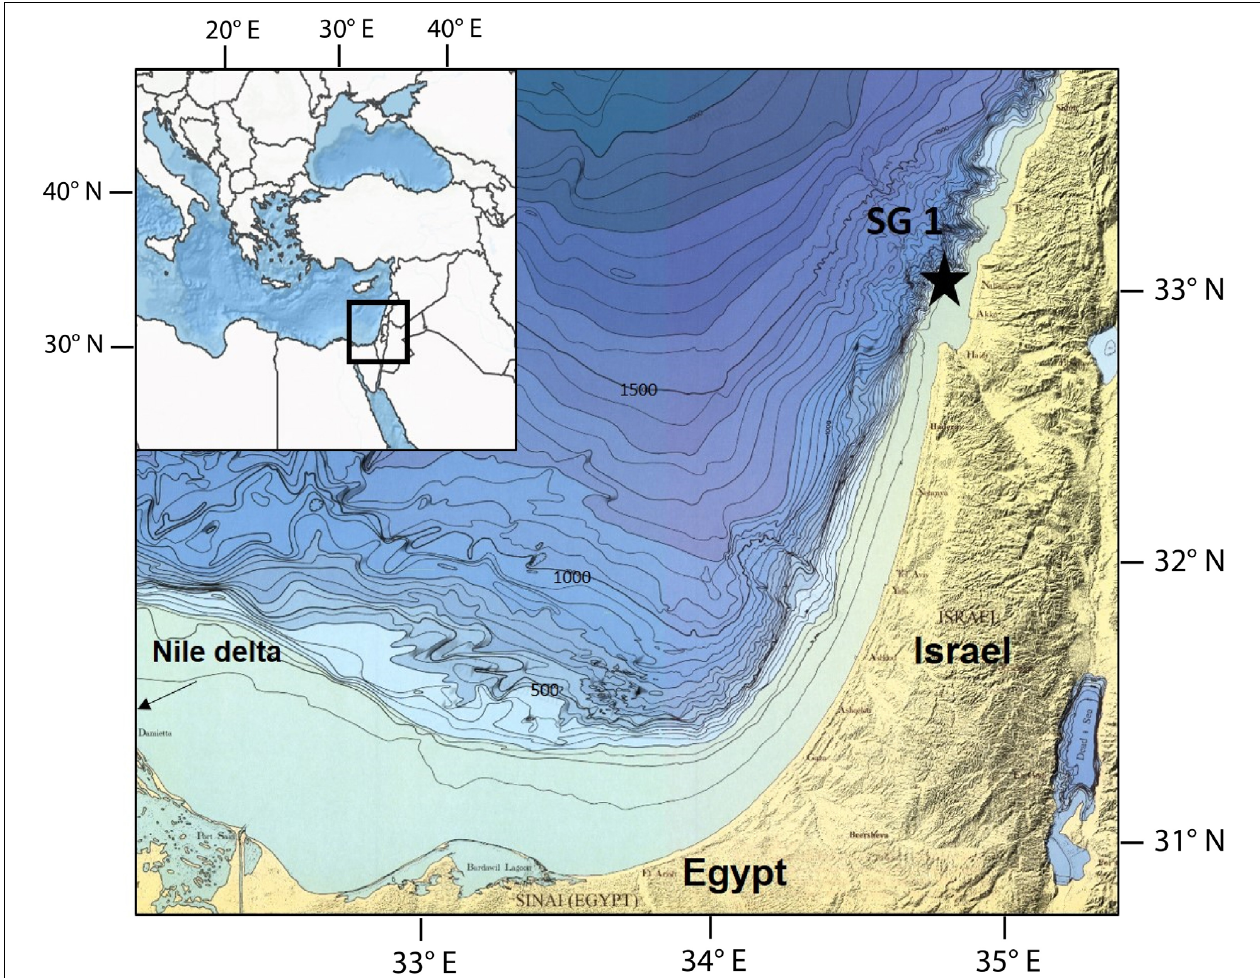
FIGURE 1 | Location map of Station SG-1 in the Southern Eastern Mediterranean Sea continental